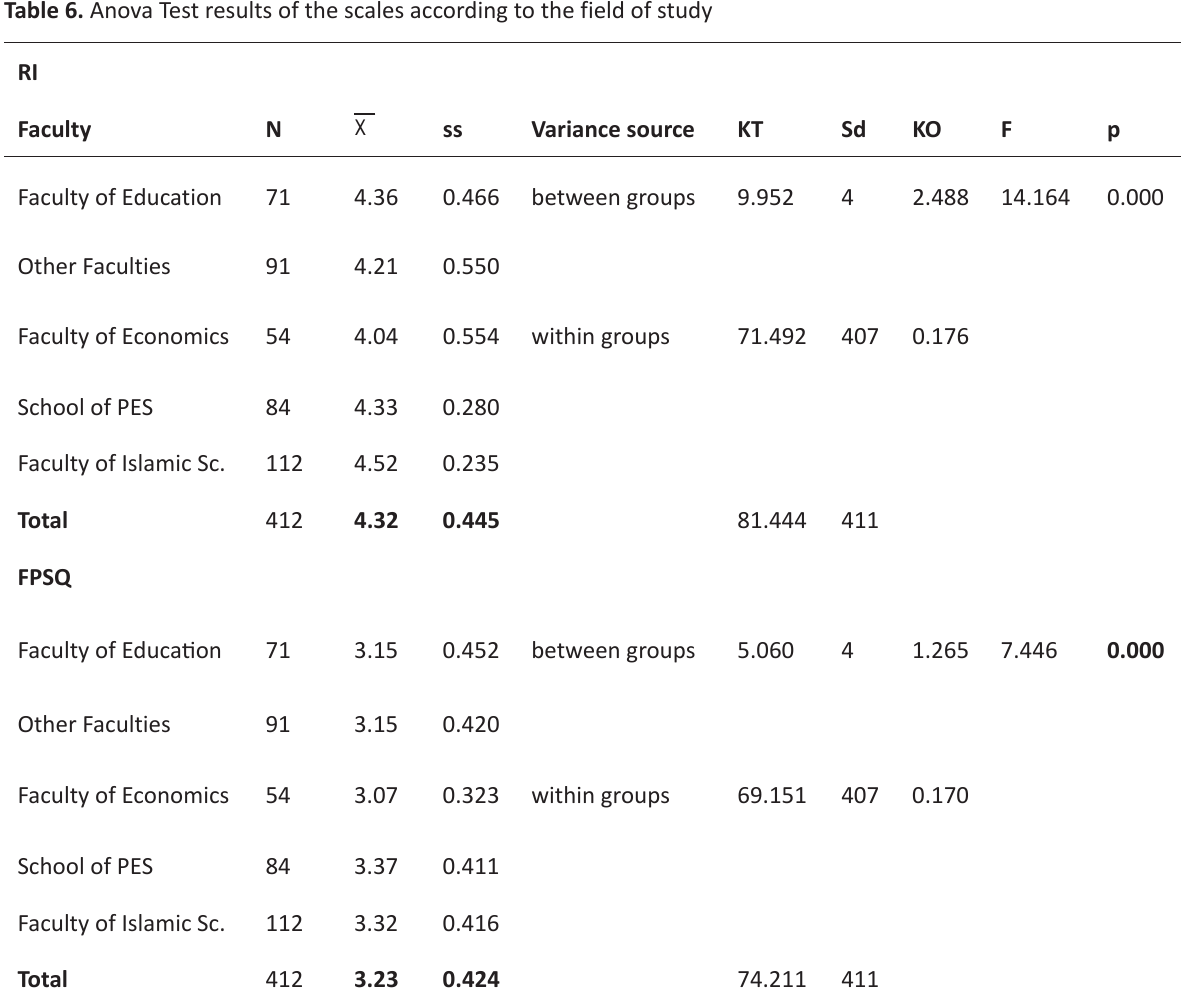
Table 6. Anova Test results of the scales according to the field of study